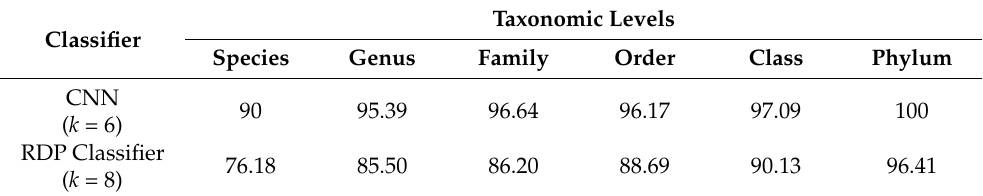
Table 9. Average classification accuracy (%) of CNN and RDP